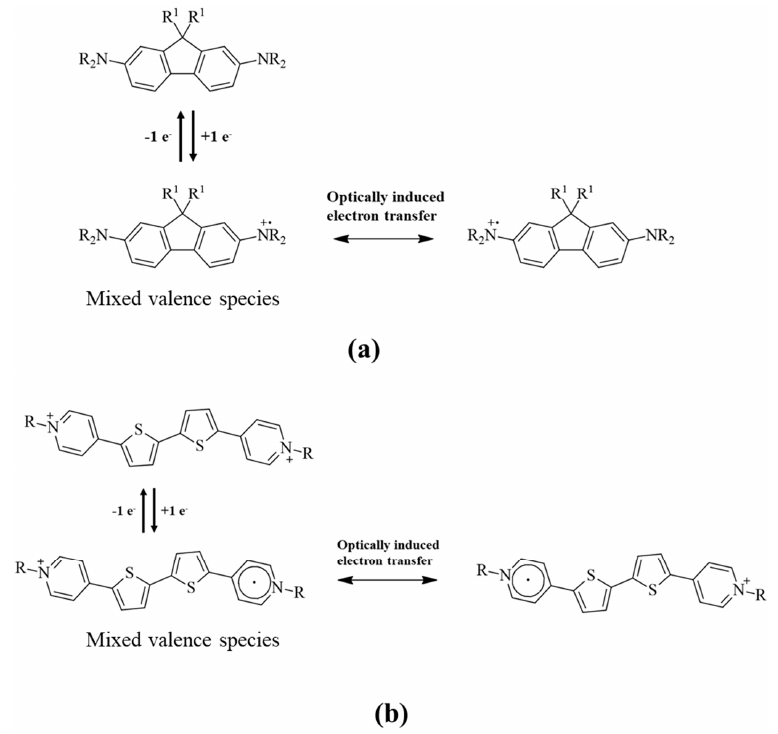
Scheme 1. Schematization of the formation of the radical cation species in the FD ( a ) and TV ( b ) mixed valence